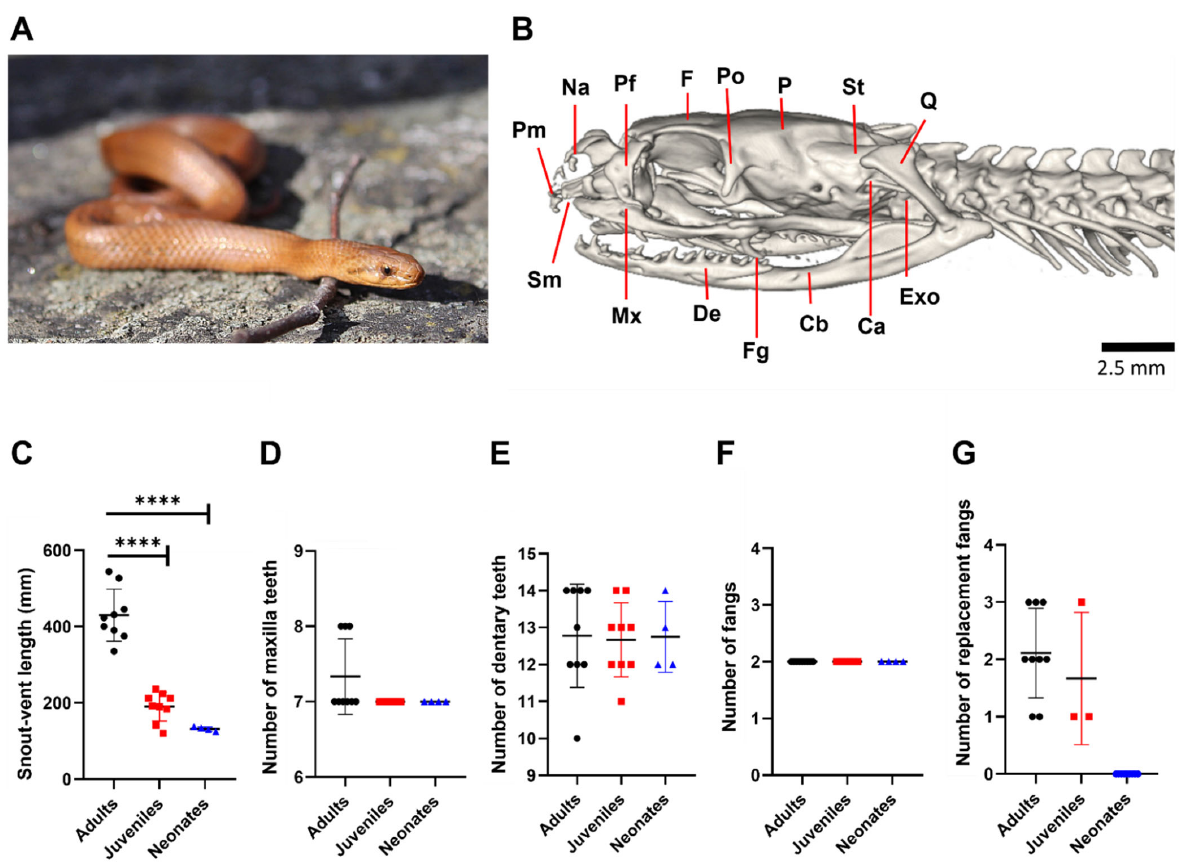
Figure 1. General features of the Galvarinus ch. chilensis dentition in different ontogenetic categories. ( A ) Image of an adult specimen from Galvarinus ch. chilensis . ( B ) Cranial osteology in the left lateral (adult specimen, MZUC 45,730) from microCT image. ( C ) Snout–vent length; number of teeth in ( D ) maxilla and ( E ) dentary bones; ( F ) number of functional and ( G ) replacement fangs of different ontogenetic categories. Data shown are mean ± SD from adults (N = 10), juveniles (N = 9), and neonates (N = 4). Abbreviations of bones: Ca = columella auris; Cb = compound bone; De = dentary; Exo = exoccipital; F = frontal; Fg = fang; Mx = maxilla; Na = nasal; P = parietal; Pf = prefrontal; Pm = premaxilla; Po = postorbital; Q = quadrate; Sm = septomaxilla; St = supratemporal. **** p < 0.0001.